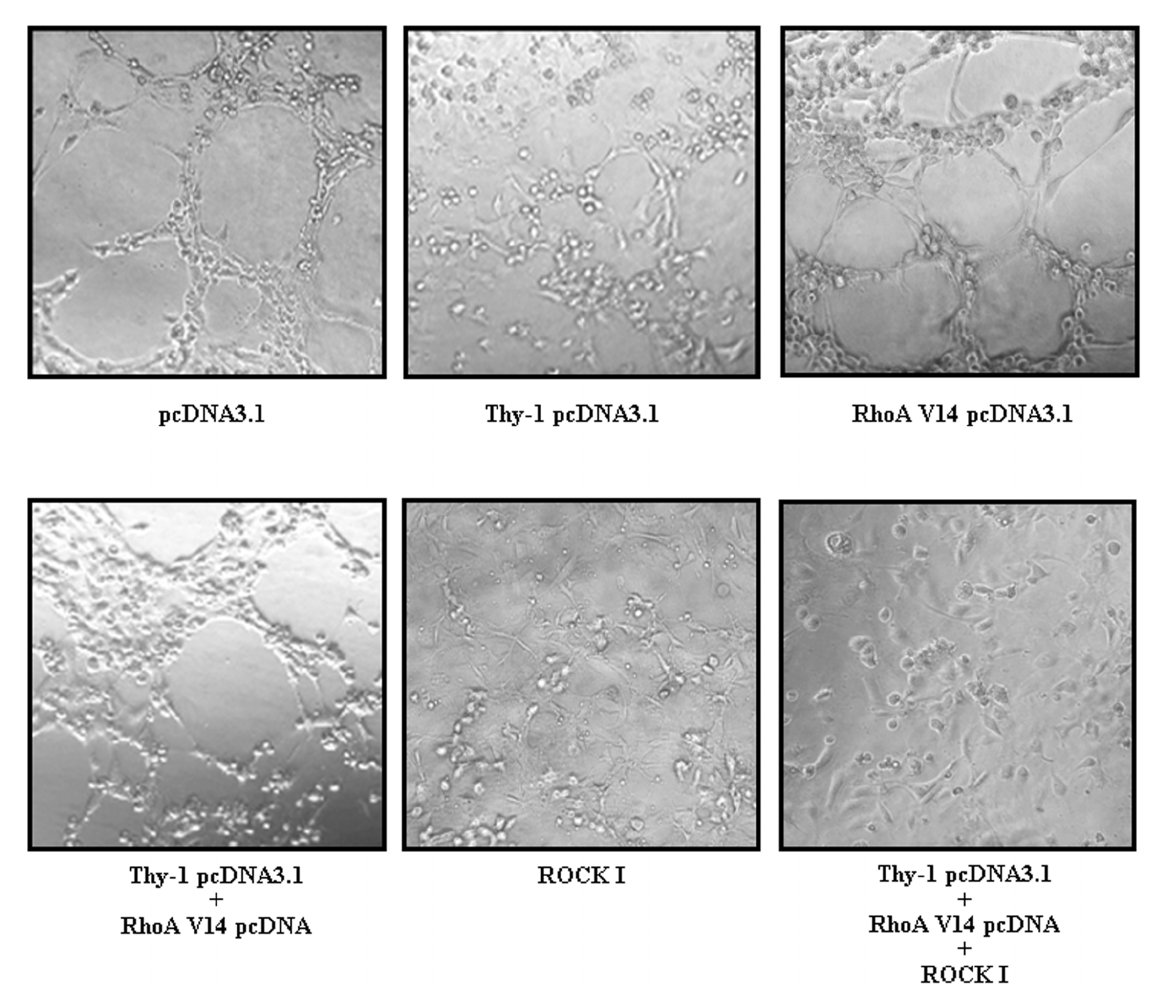
Figure 6. Involvement of Rho/ROCK signaling pathway in the Thy-1-induced inhibition in capillary-like tube formation. Over- expression of Thy-1 inhibited the capillary-like tube formation. However, co-transfection of Thy-1-transfected HUVEC with RhoA V14 prevented the Thy-1-induced inhibition of capillary-like tube formation. Treatment with 5 m M Y-27632 inhibited capillary-like formation and abolished the RhoA V14-induced prevention effect on Thy-1-mediated inhibition of capillary-like tube